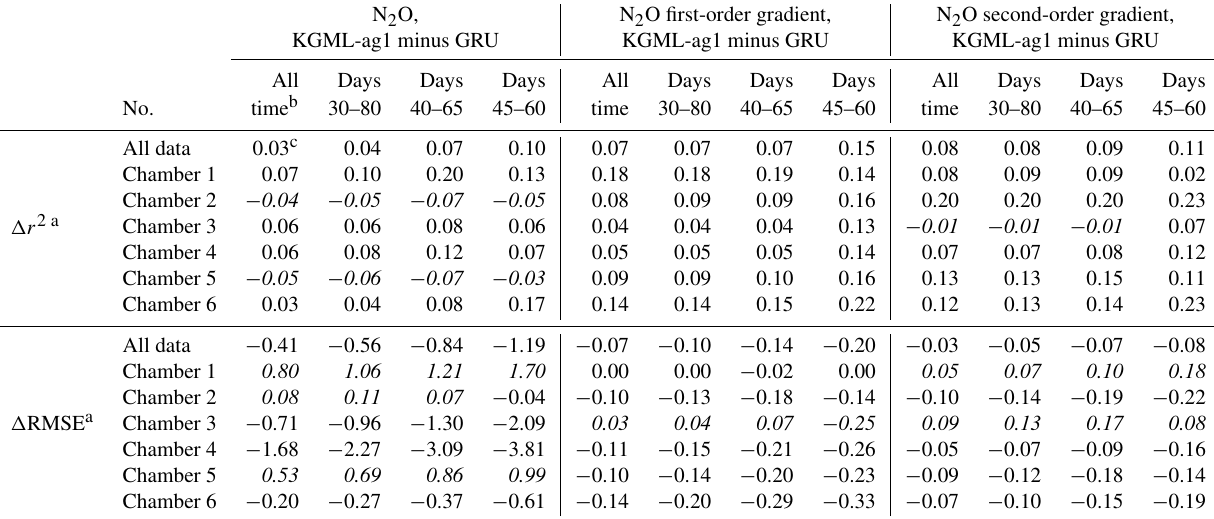
Table 2. Prediction accuracy comparisons between non-pre-trained GRU model and